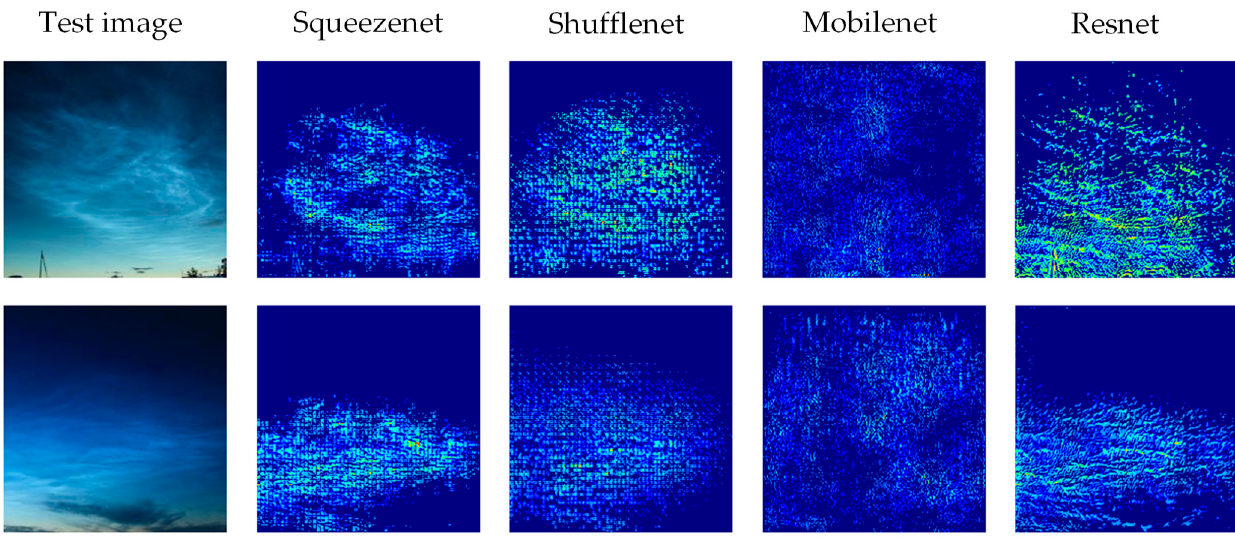
Figure 3. Test images and their saliency map for NLC class.